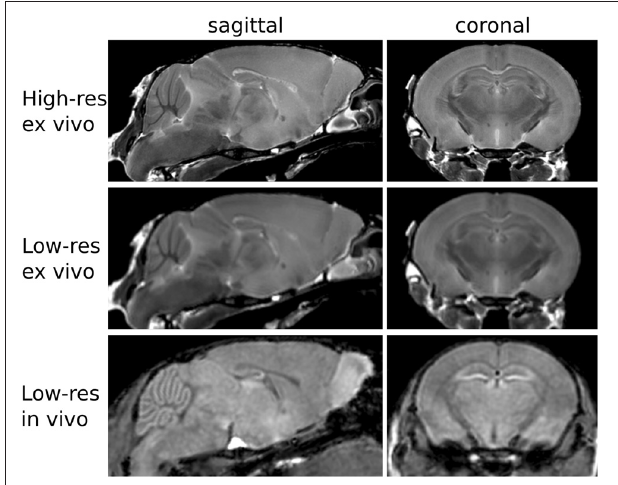
FIGURE 2 | Sample images from the three acquisitions used in this study are shown here.